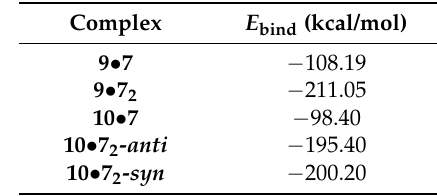
Table 6. Binding energies computed at the B97-D3/(cc-pVTZ+LANL2DZ) level for the